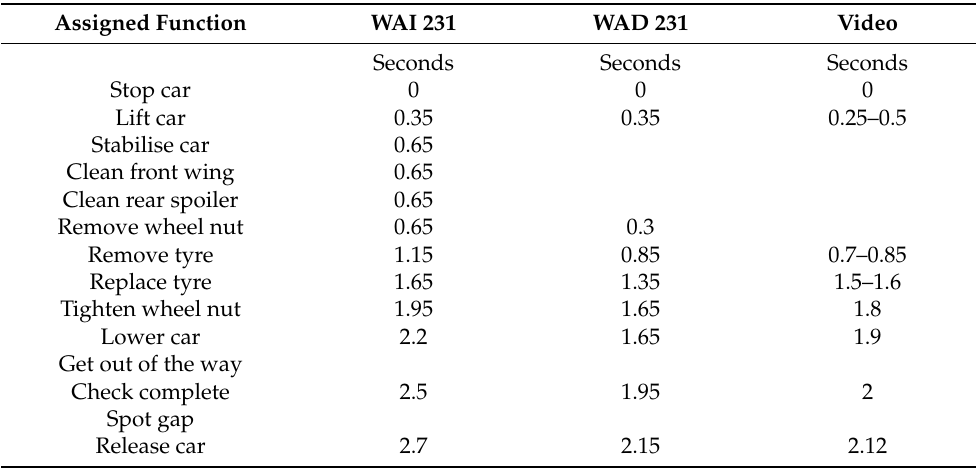
Table 4. Comparison of predicted and actual timings for the pit